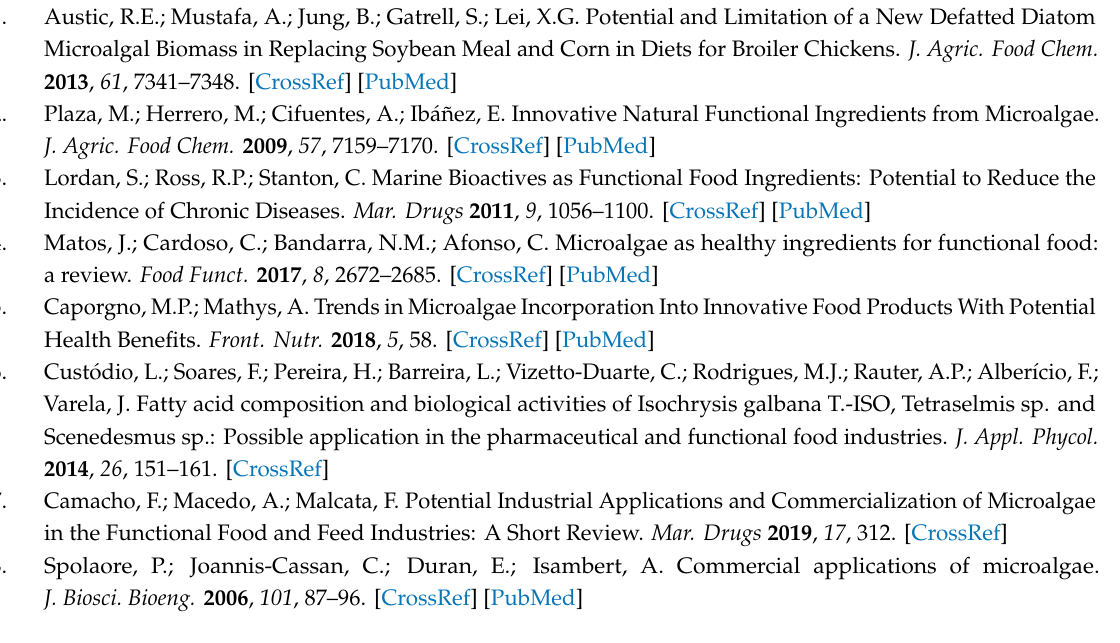
Table S1: Fatty acid profile of Tetraselmis sp. CTP4 grown in an industrial production facility., Table S2: Glycosidic-linkage analysis (mol%) of Tetraselmis sp. CTP4 grown semi-continuously in industrial tubular photobioreactors., Table S3: Composition of minerals and heavy metals of Tetraselmis sp. CTP4 biomass grown semi-continuously in industrial tubular